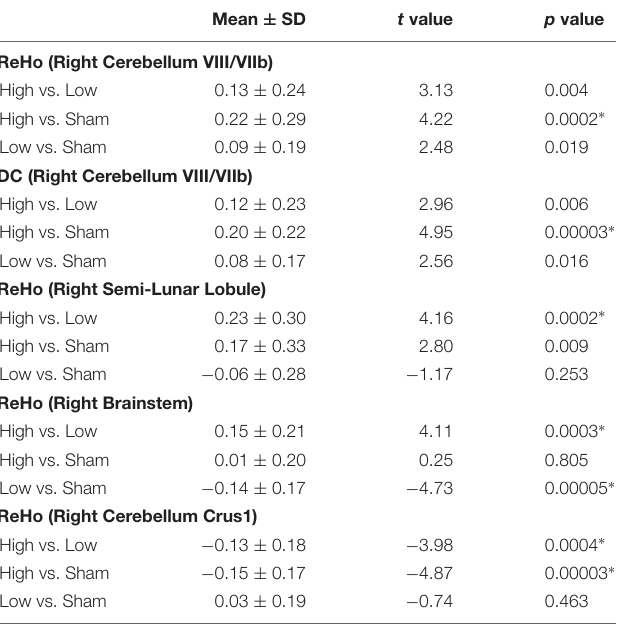
TABLE 3 | Differences between stimulation conditions in the right cerebellum (paired t tests).